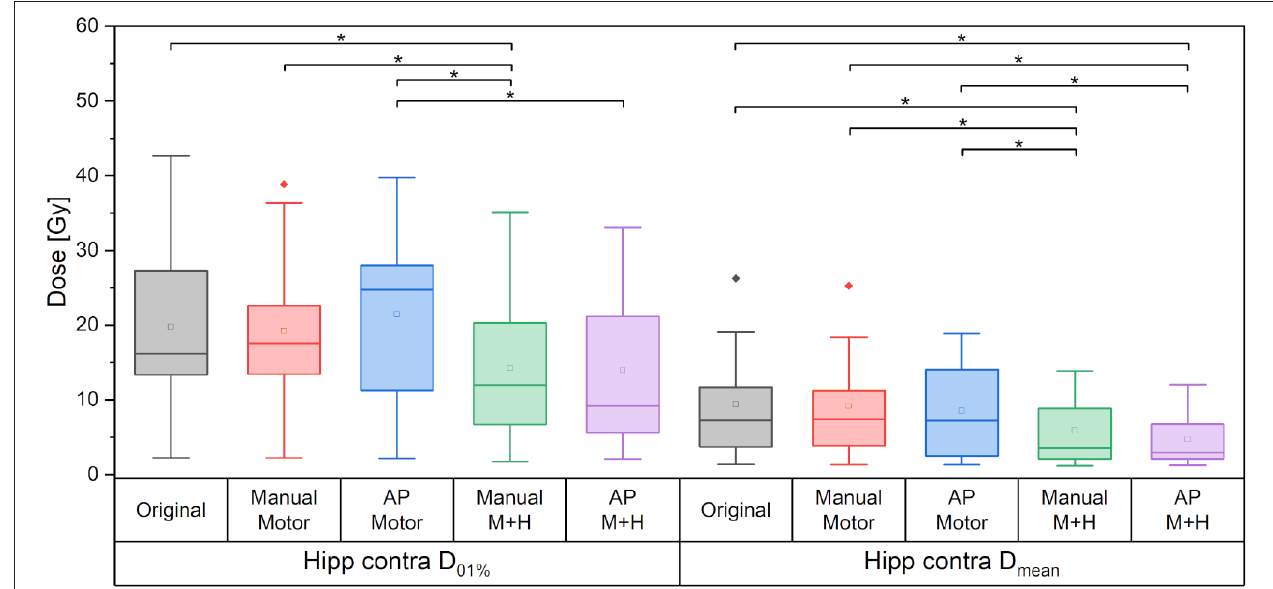
FIGURE 11 | Maximum and mean dose to the contralateral hippocampus. Line = median value, square = mean value, diamond = outliers, star = statistically significant p < 0.005.